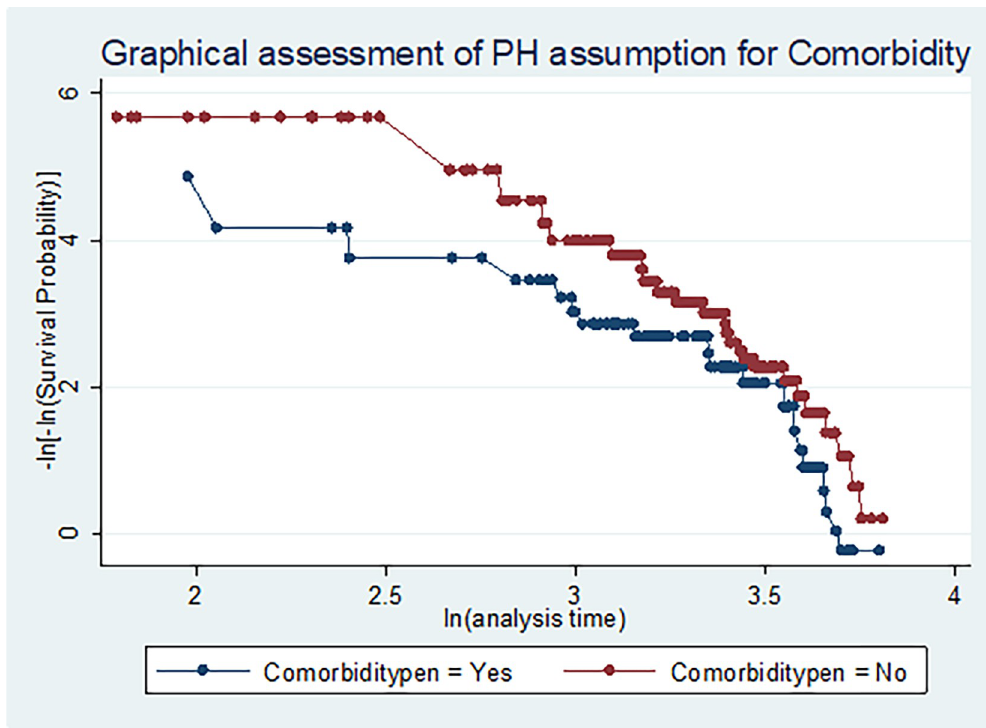
Fig 8. Graphical assessment of assumption of proportional hazards for types of comorbidity. https://doi.org/10.1371/journal.pone.0269576.g008 PLOS ONE | https://doi.org/10.1371/journal.pone.0269576 June 24,